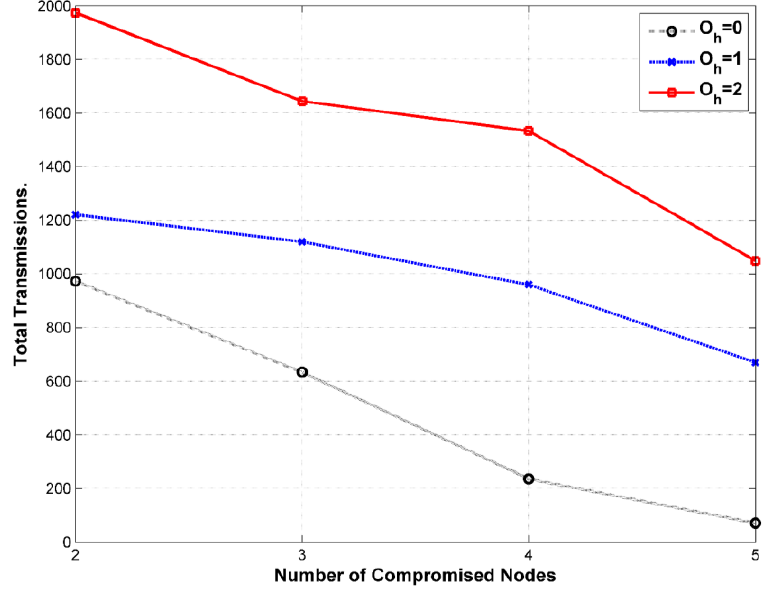
Figure 20. Protecting the BS by having onion encryption. Increasing O h and decreasing the number of compromised nodes will increase the total number of messages successfully transmitted to the BS before it is